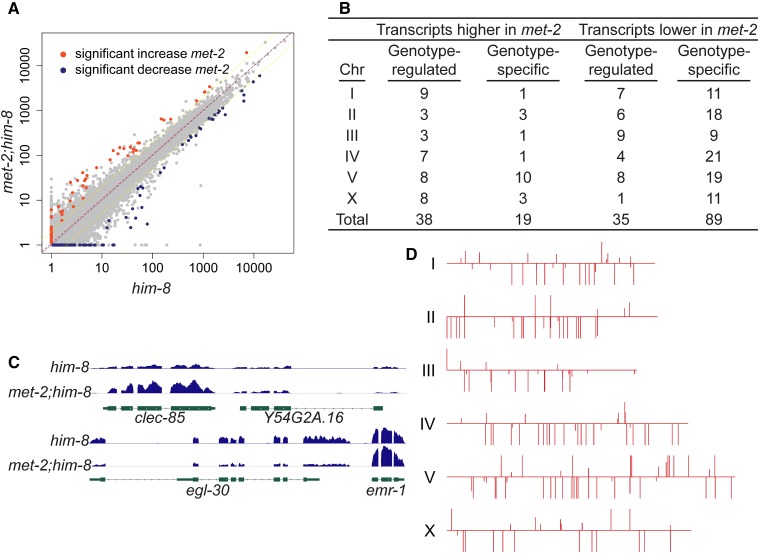
The effect of histone H3 lysine 9 dimethylation (H3K9me2) loss on the adult hermaphrodite gonad transcriptome. (A) Scatter plot represents the transcriptome data from him-8 gonads vs.
met-2;him-8 gonads. Transcripts present at a statistically different level are highlighted in red if more highly expressed in met-2;him-8 and blue if more highly expressed in him-8. X- and Y-axis scale is expressed in RPKM (see text). (B) The table lists the number of genes on each chromosome with transcripts that are differentially abundant in met-2; him-8
vs.
him-8 gonads. These represent the highlighted transcripts in (A). (C) Screen shots of representative differential transcripts: clec-85 transcripts are elevated in met-2;him-8 and egl-30 transcripts are reduced in met-2;him-8. Transcripts from adjacent genes, Y54G2A.16 and emr-1, are statistically unchanged. (D) Chromosomal distribution of genes whose transcripts are differentially abundant in met-2;him-8
vs.
him-8. Lines extending upward indicate transcripts that are more abundant in met-2; him-8, and lines extending downward indicate transcripts that are less abundant in met-2;him-8. Longer lines represent “genotype-specific” genes whose transcripts are detected in one genotype and not the other. Shorter lines represent genotype-regulated genes whose transcripts are more abundant in one genotype than the other; their length is proportional to the log2 value of the fold-change.